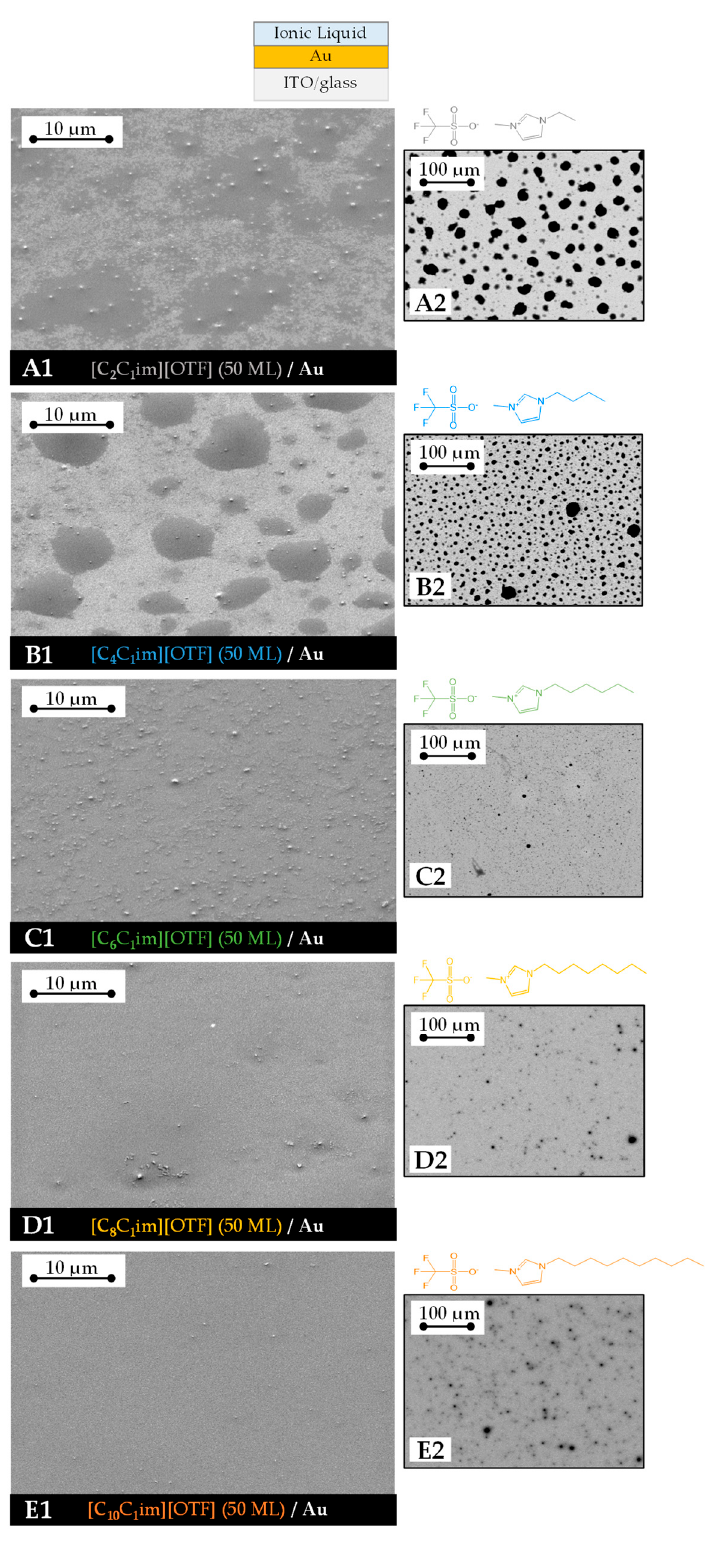
Figure 4. Micrographs acquired through high-resolution scanning electron microscopy of thin ionic liquid films (50 monolayers, ML) of [C 2 C 1 im][OTF] ( A1 , A2 ), [C 4 C 1 im][OTF] ( B1 , B2 ), [C 6 C 1 im][OTF] ( C1 , C2 ), [C 8 C 1 im][OTF] ( D1 , D2 ), and [C 10 C 1 im][OTF] ( E1 , E2 ) deposited onto surfaces of Au/ITO/glass. Lateral views at 45° (magnification of 5000×) obtained by secondary electron imaging ( A1 – E1 ) and top views (magnification of 500×) obtained by backscattered electron imaging ( A2 – E2 ).